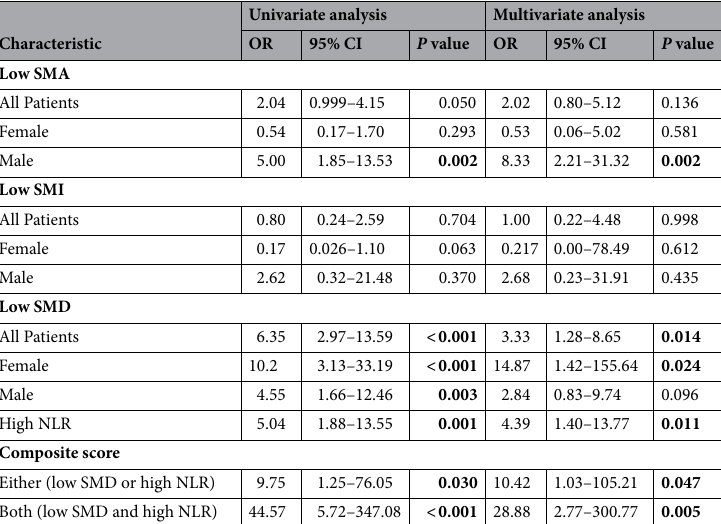
Table 4. Univariate and multivariate Cox regression analyses of death probability according to low muscularity, low muscle radiodensity, high neutrophil-to-lymphocyte ratio and composite score in patients with COVID-19. The Cox model was adjusted for age (continuous), BMI (continuous), ≥ 1 comorbidities (categorical), ≥ 2 comorbidities (categorical), creatinine (categorical), hemoglobin (categorical), alanine aminotransferase (categorical), sodium (categorical), and prothrombin time (categorical) and covariate missing data was completed with the variable median. CI confidence interval, OR odds ratio, NLR neutrophil- to-lymphocyte ratio, SMA skeletal muscle area, SMD skeletal muscle radiodensity, SMI skeletal muscle index. Bold indicates P value is statistcally